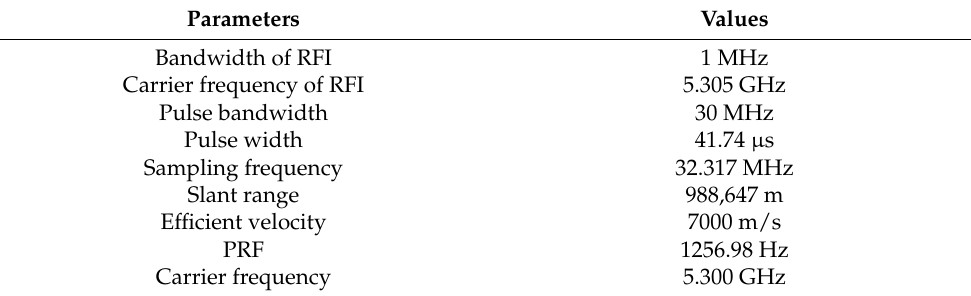
Table 1. Parameters of the simulated RFI and measured SAR data. Parameters Values Bandwidth of